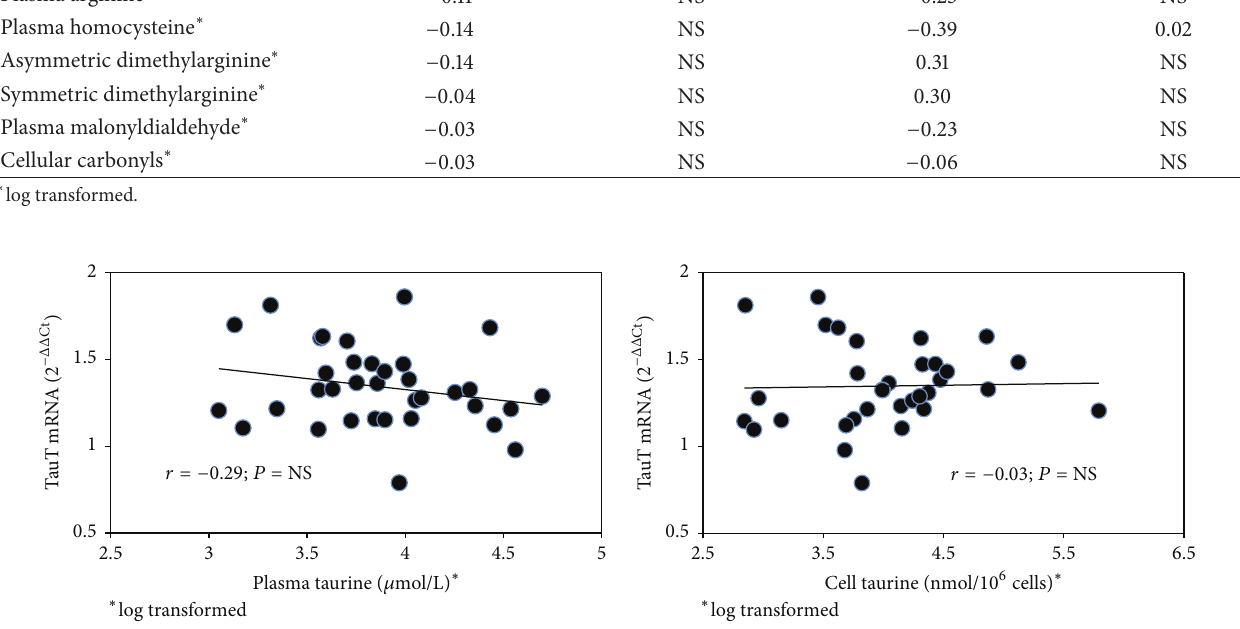
Figure 2: Relation between TauT mRNA gene expression and plasma (a), or cell taurine (b), in MPCs from type 1 diabetic patients.